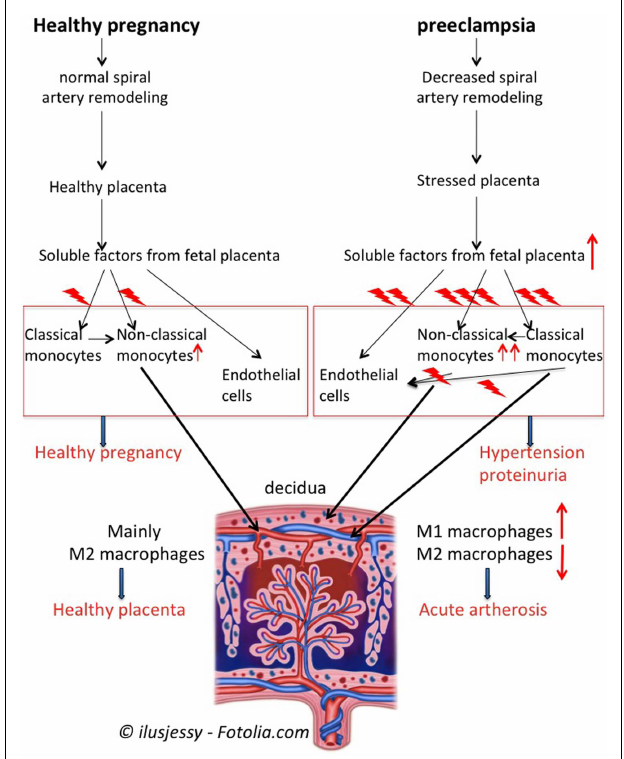
FIGURE 4 | Summary of monocytes and macrophages in pregnancy and pre-eclampsia . In healthy pregnancy, soluble factors from the villous trophoblast activate circulating monocytes, induce maturation of classical monocytes toward non-classical monocytes and affect endothelial cells. Non-classical monocytes will invade into the decidua to become M2-like macrophages to support healthy placentation and immunomodulation. During pre-eclampsia, decreased remodeling of the spiral arteries will results in a stressed placenta, which produces increased amounts or different soluble factors as compared with healthy pregnancy.The soluble factors will further activate the monocytes, induce further maturation of classical monocytes toward non-classical monocytes and activate endothelial cells. Activated monocytes, by f.i. producing cytokines, further affect monocytes and endothelial cells.This vicious circle of monocyte and endothelial cell activation results in the maternal symptoms of pre-eclampsia, i.e., hypertension and proteinuria. Moreover, activated classical and non-classical monocytes may invade into the decidua to develop into M1-like and M2-like macrophages, resulting in increased numbers of M1-like macrophages in the pre-eclamptic decidua.The M1-like macrophages may affect the spiral arteries resulting in f.i.